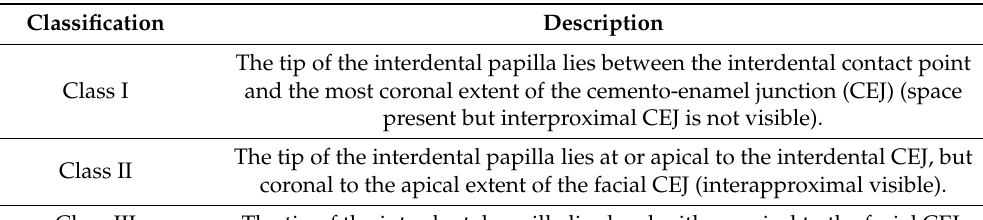
Table 1. Classification system by Nordland and Tarnow [35].